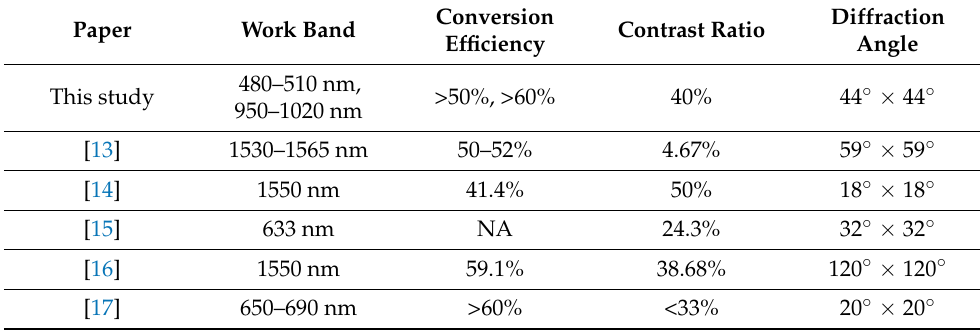
Table 1. Comparison with previous